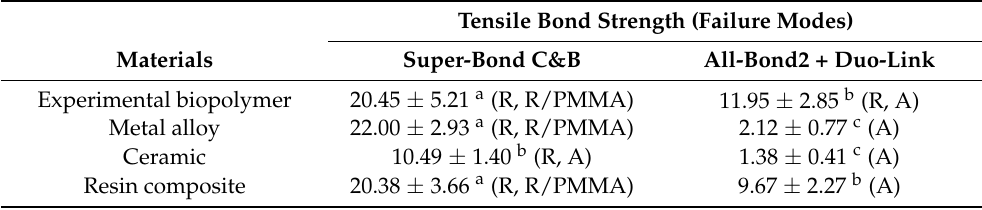
Table 4. Mean ± SD of tensile bond strength (MPa) and failure modes for all groups ( n =